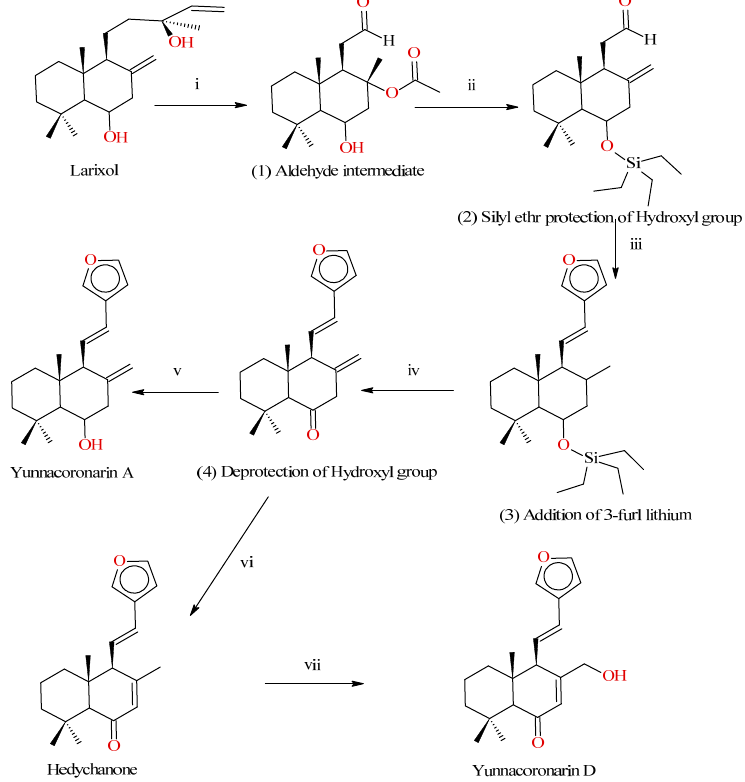
Figure 5. Synthesis of Hedychenone and Yunnacoronarin D: Reagents and conditions: (i) osmium tetroxide/sodium periodate oxidation sequence (50%); (ii) (1) Et 3 SiCl, DMAP cat, py, 8 h (94%), (2)